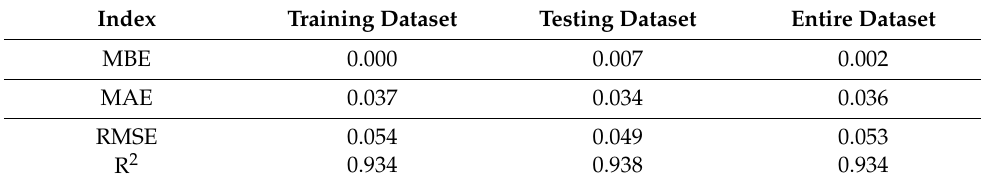
Figure 4. Scatterplot of the measured and predicted data for the training and testing datasets. Table 1. Performance indices for the ANFIS model